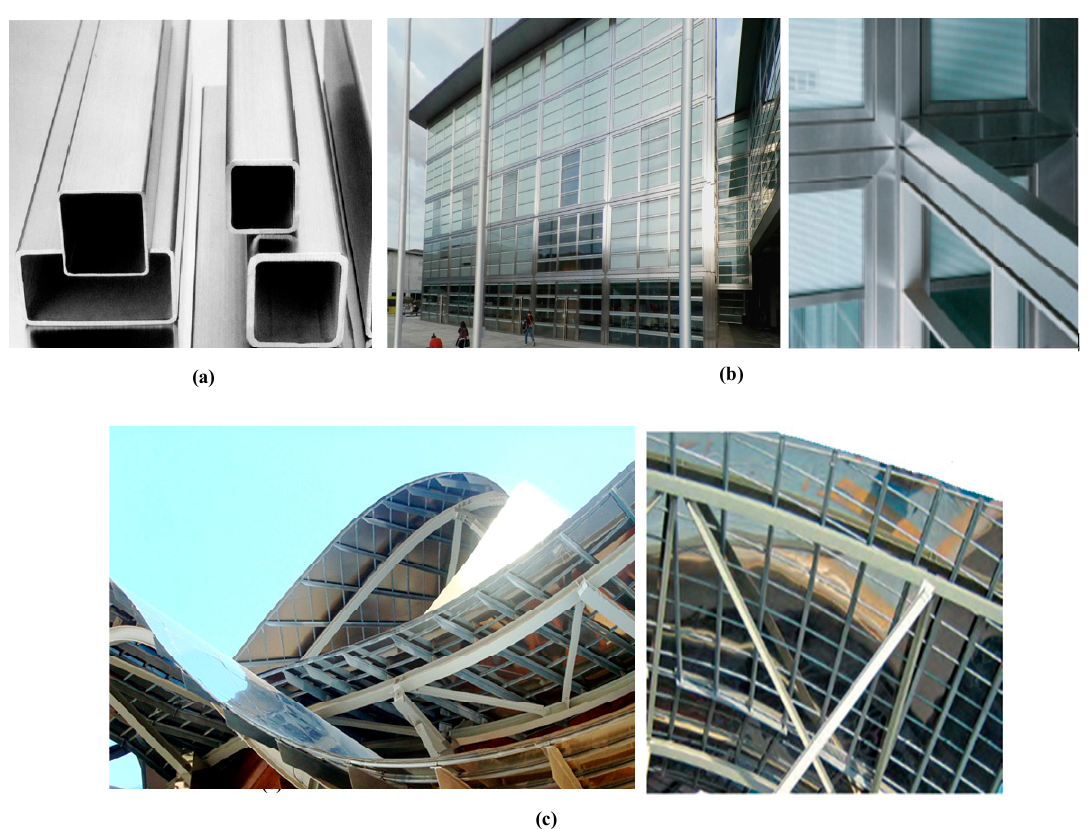
Figure 2. Cold-formed stainless steel rectangular hollow section (RHS) and square hollow section (SHS) and their applications in construction industry. ( a ) Cold-formed stainless steel RHS and SHS; ( b ) facade of the building of department of Chemistry, ETH Zürich (Switzerland); ( c ) support frame of Marqués de Riscal Vineyard (Spain).